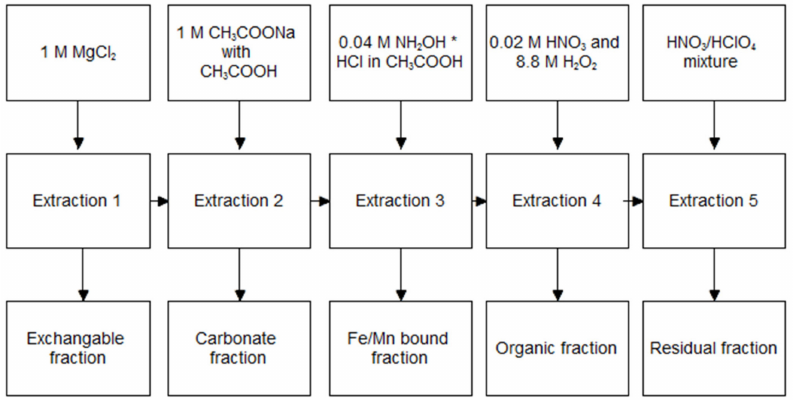
Figure 1. Tessier speciation